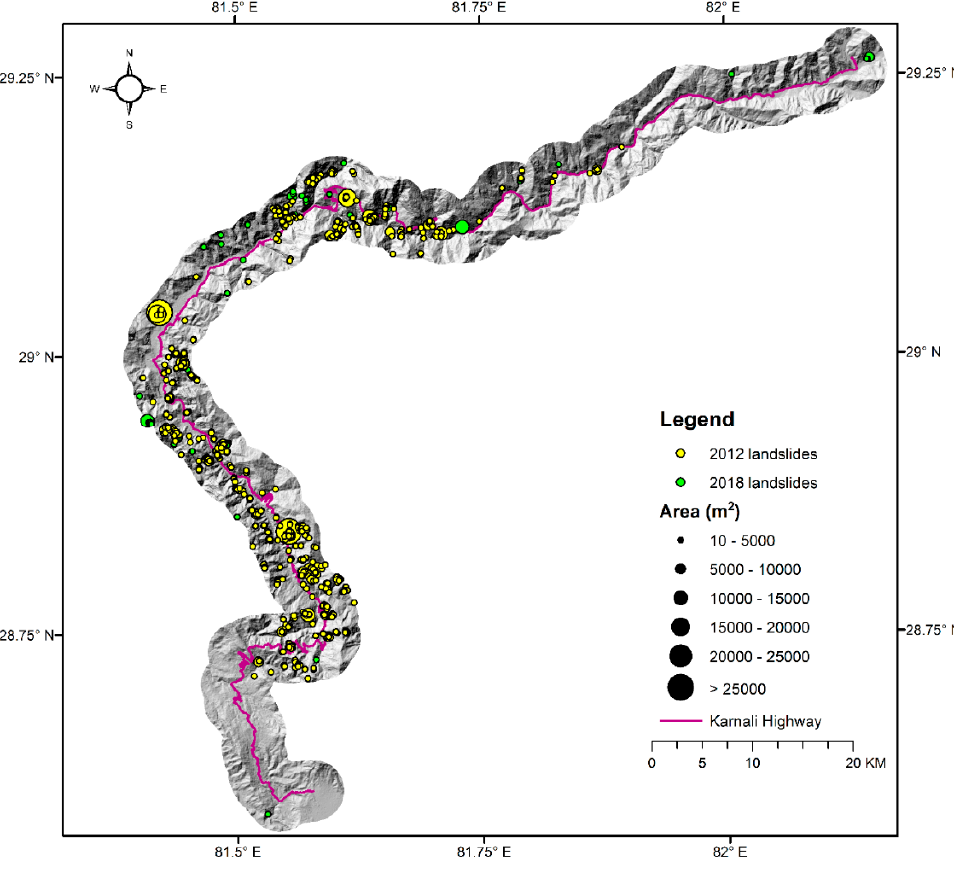
Figure 7. Location and area of landslides along the Karnali highway for the two mapping periods, 2012 and 2018.